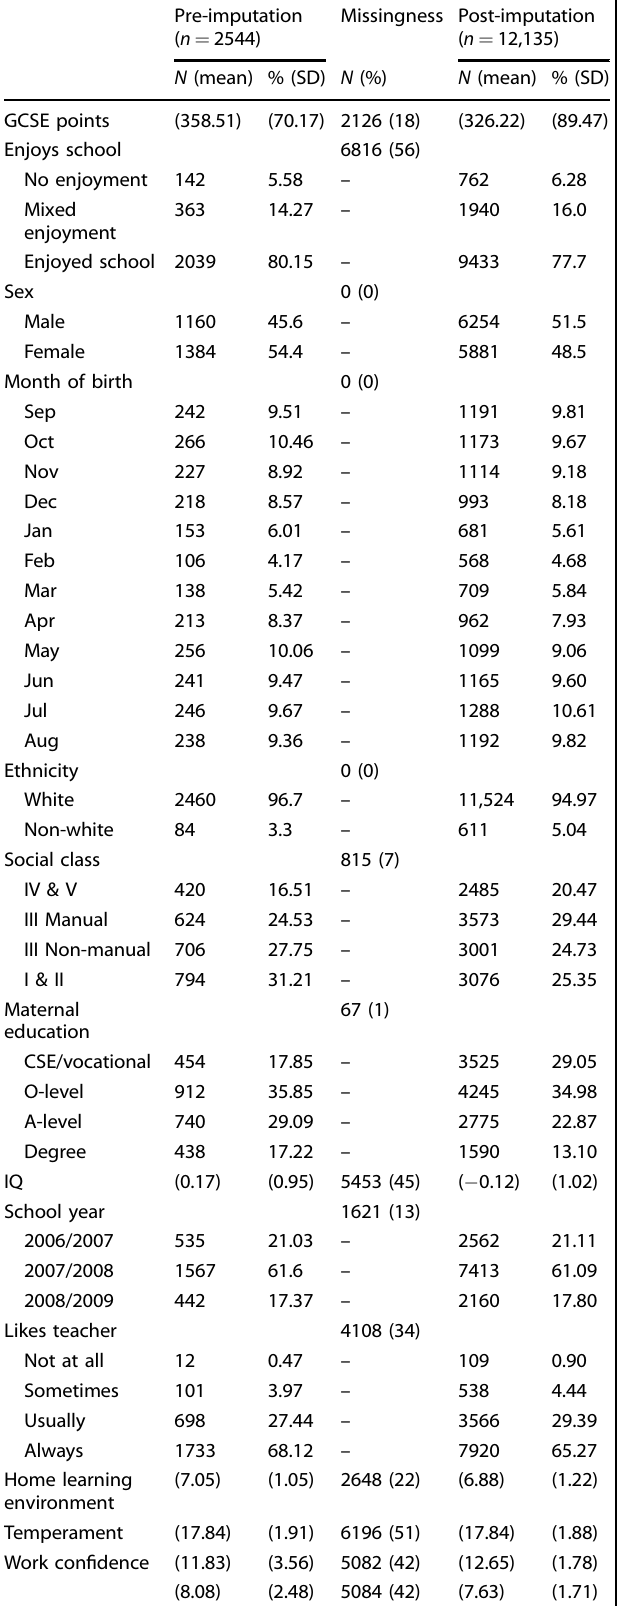
Table 1. Descriptive statistics from complete case and multiple imputation samples.